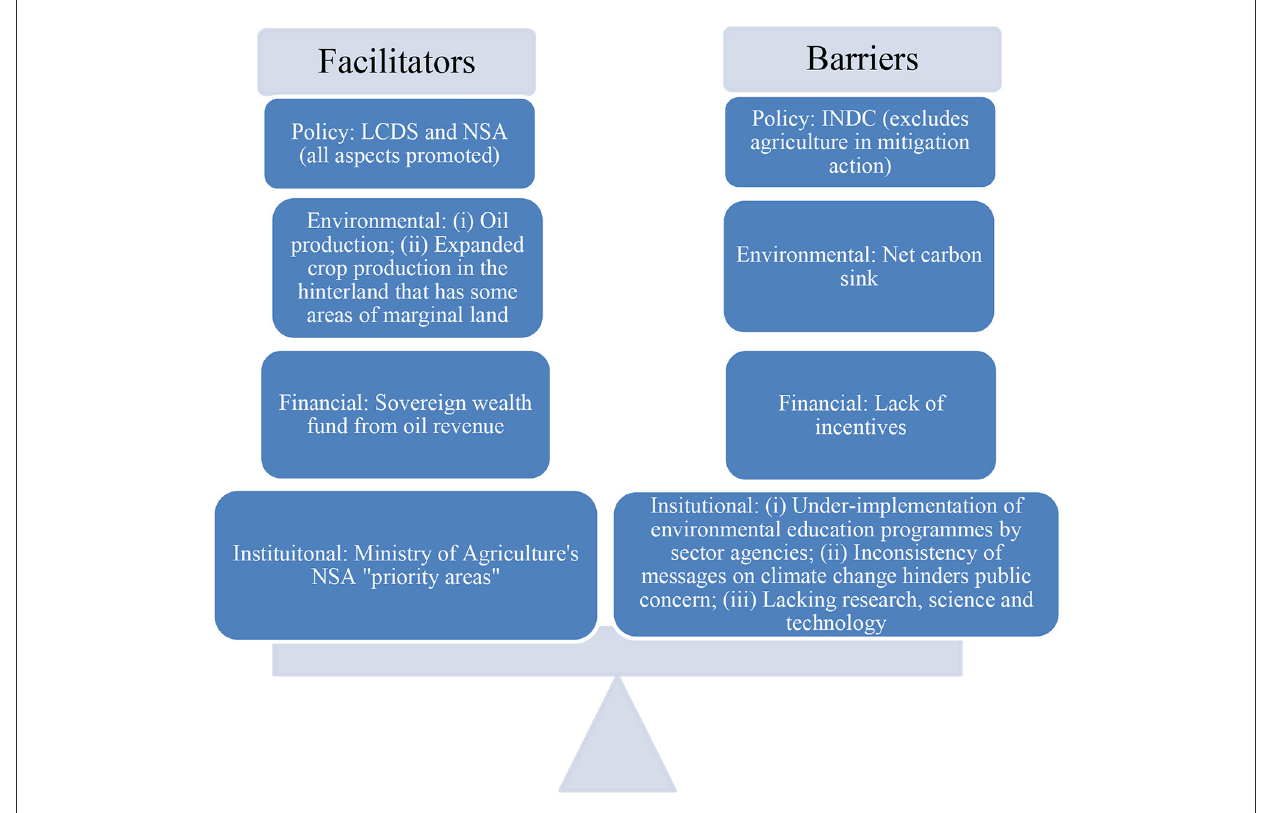
FIGURE1 Facilitators of and barriers to CSA in Guyana.